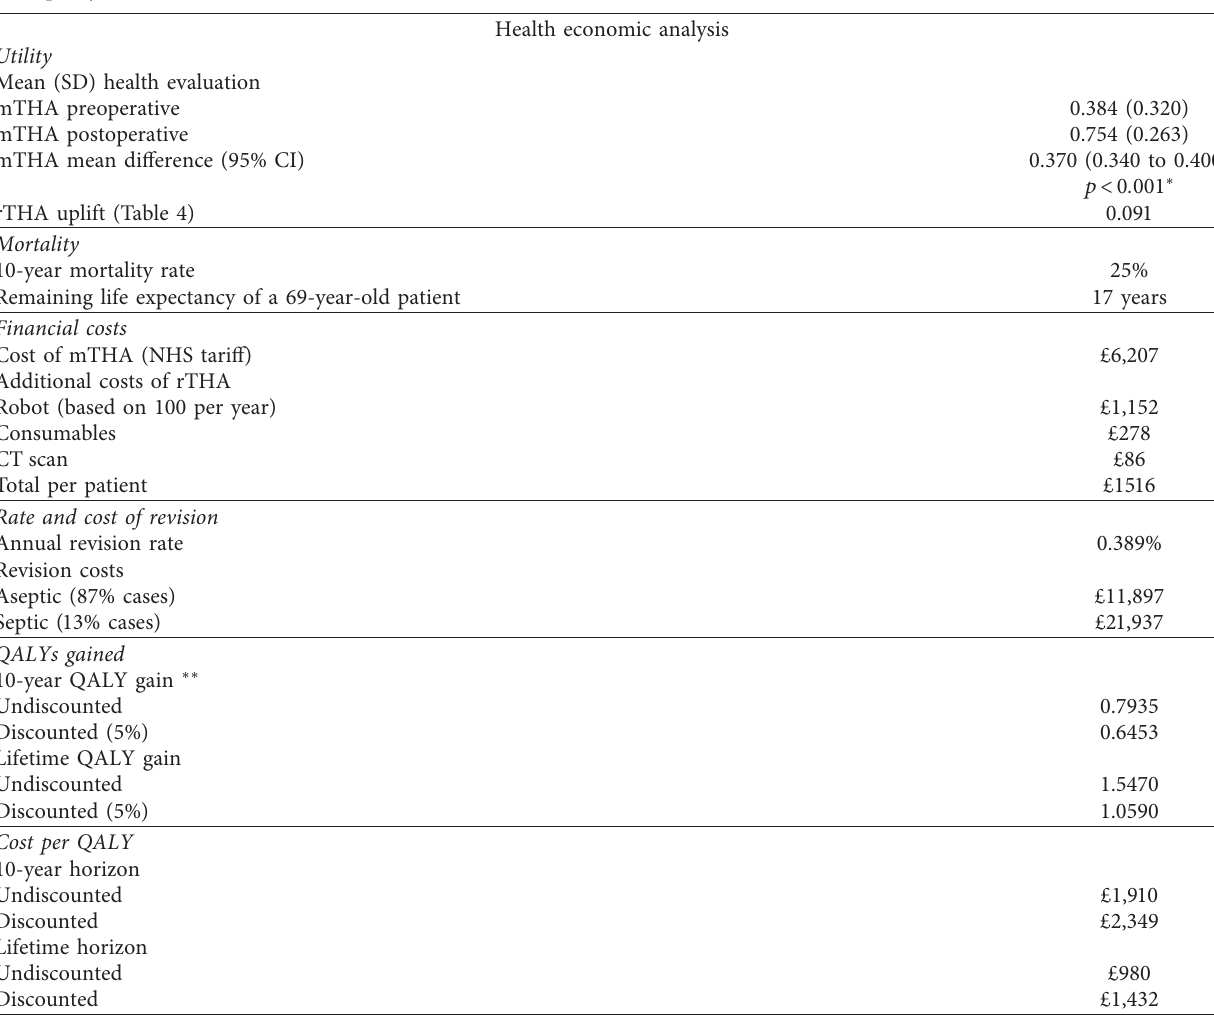
Table 5: Health economic analysis for lifetime cost per QALY for manual total hip arthroplasty (mTHA) and robotic arm-assisted total hip arthroplasty